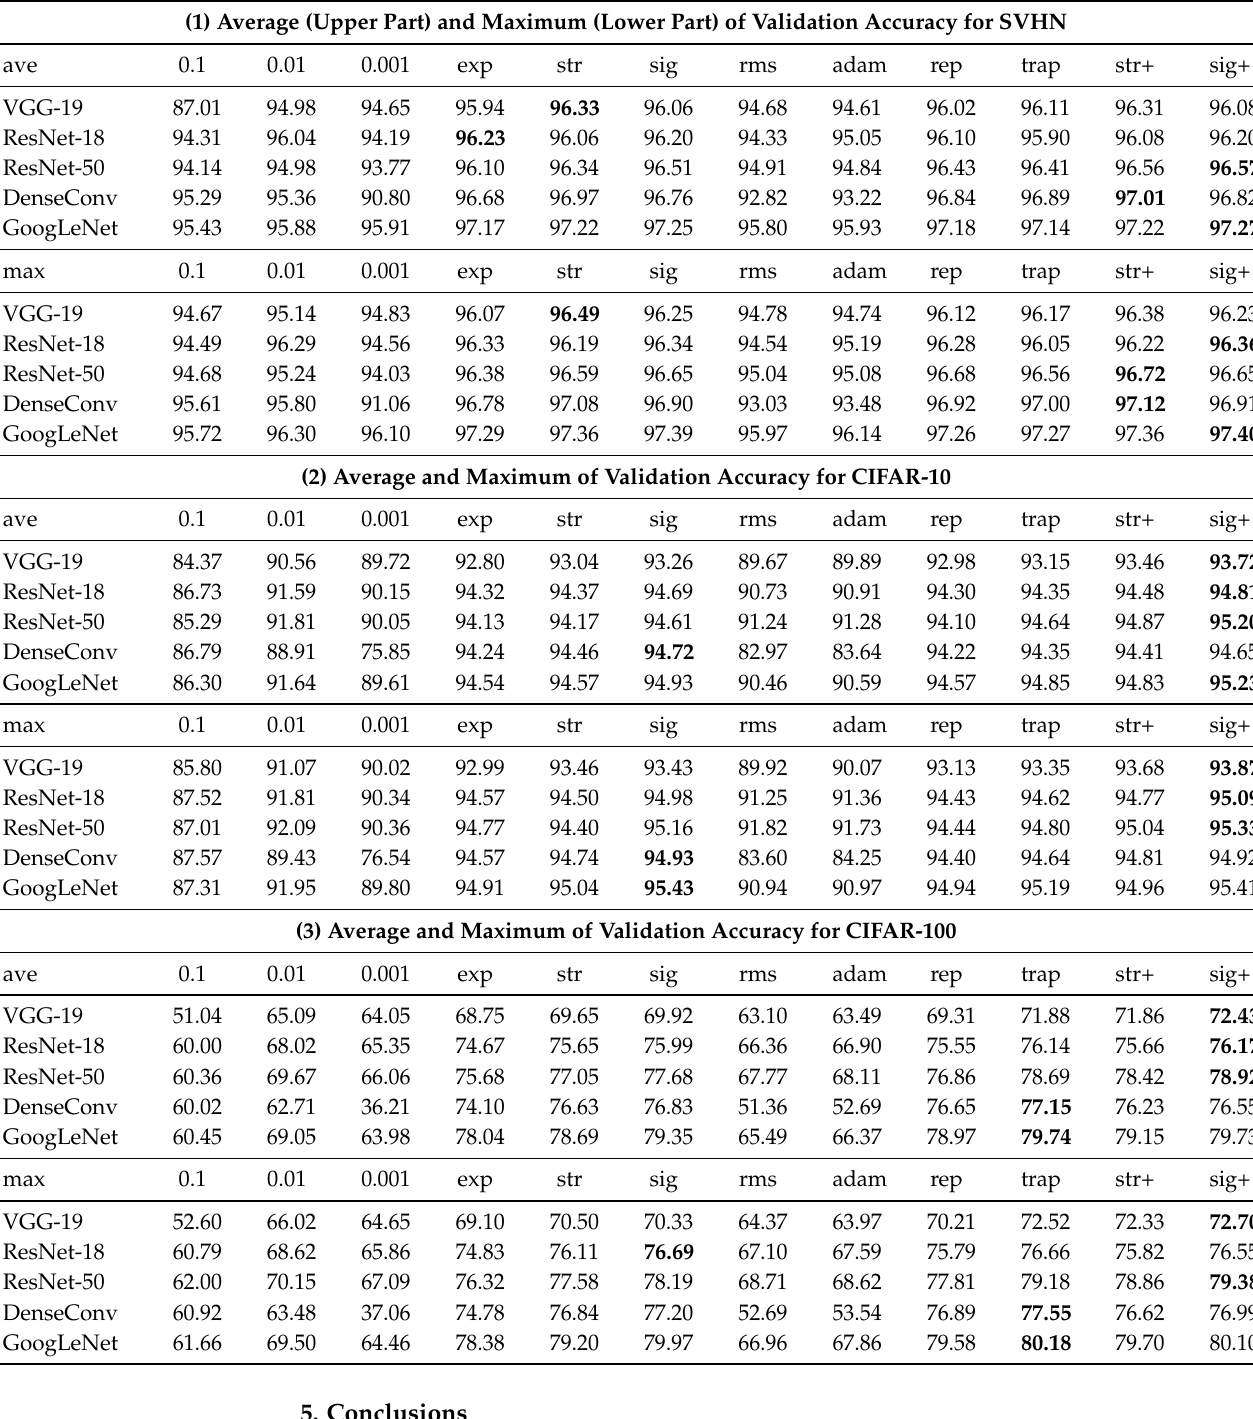
Table 3. Validation accuracy by SGD with different learning rate annealings: constant learning rate η = 0.1,0.01,0.001, exponential function (exp), staircase (str), sigmoid function (sig), RMSprop (rms), Adam (adam), twice-repeated